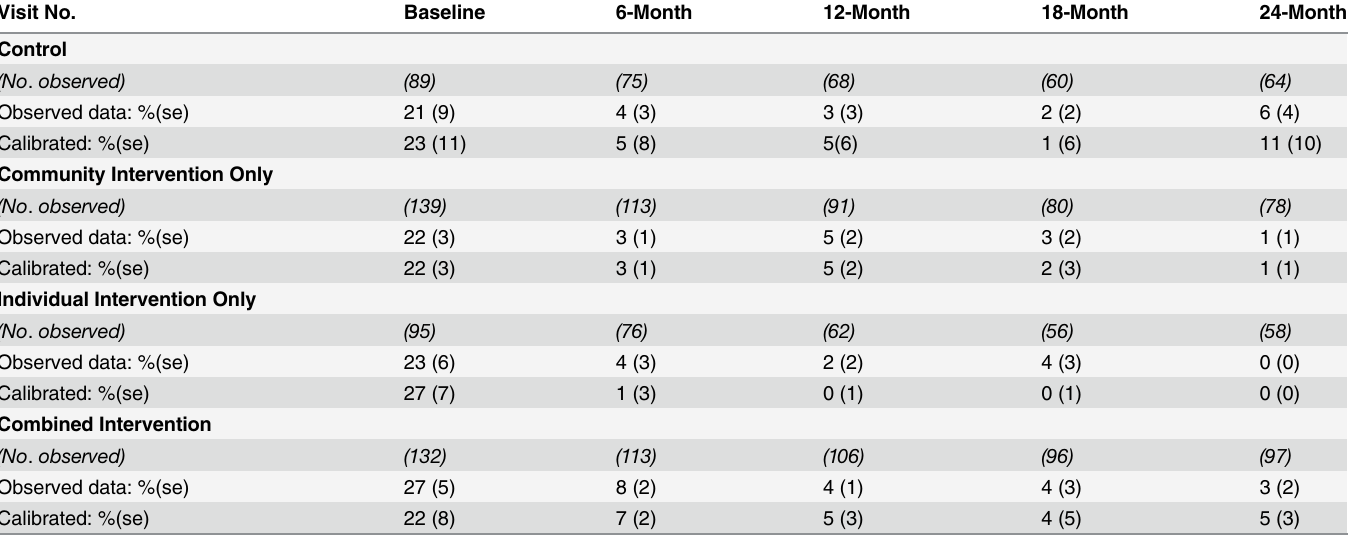
Table 4. Percent and standard error (se) of index participants who had unprotected sex in the past 3 months. Visit